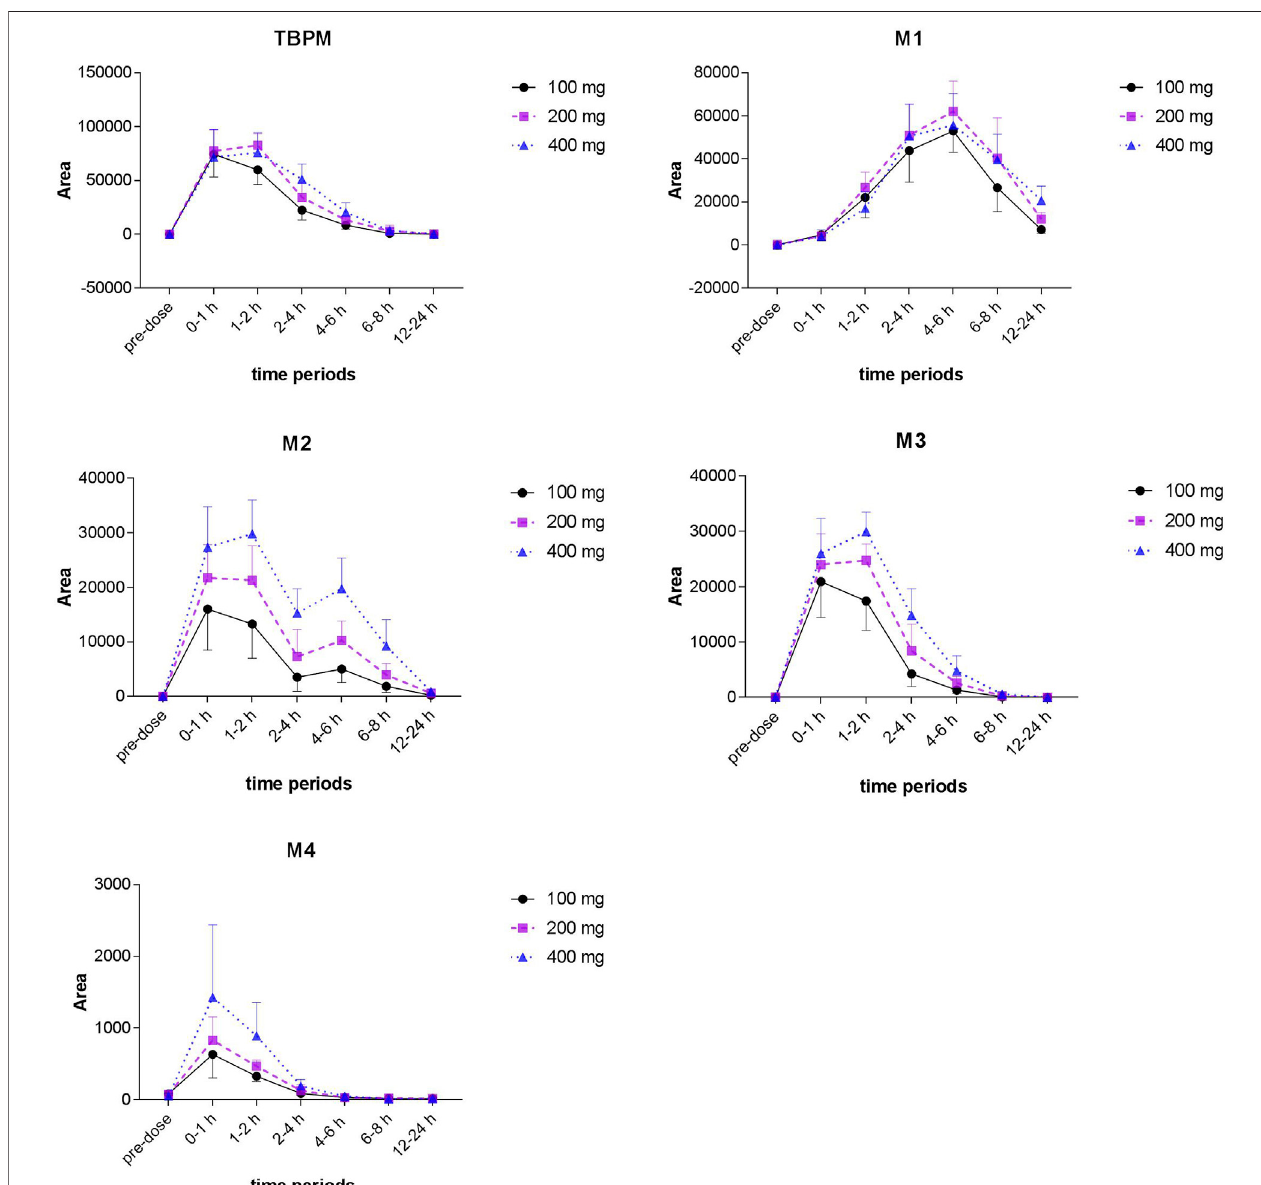
FIGURE5| Area – timepro fi lesofTBPM,M1toM4detectedinurineafterasingleoraldoseof100,200,or400 mginhealthyChinesesubjects( n (cid:2) 12foreachdose).